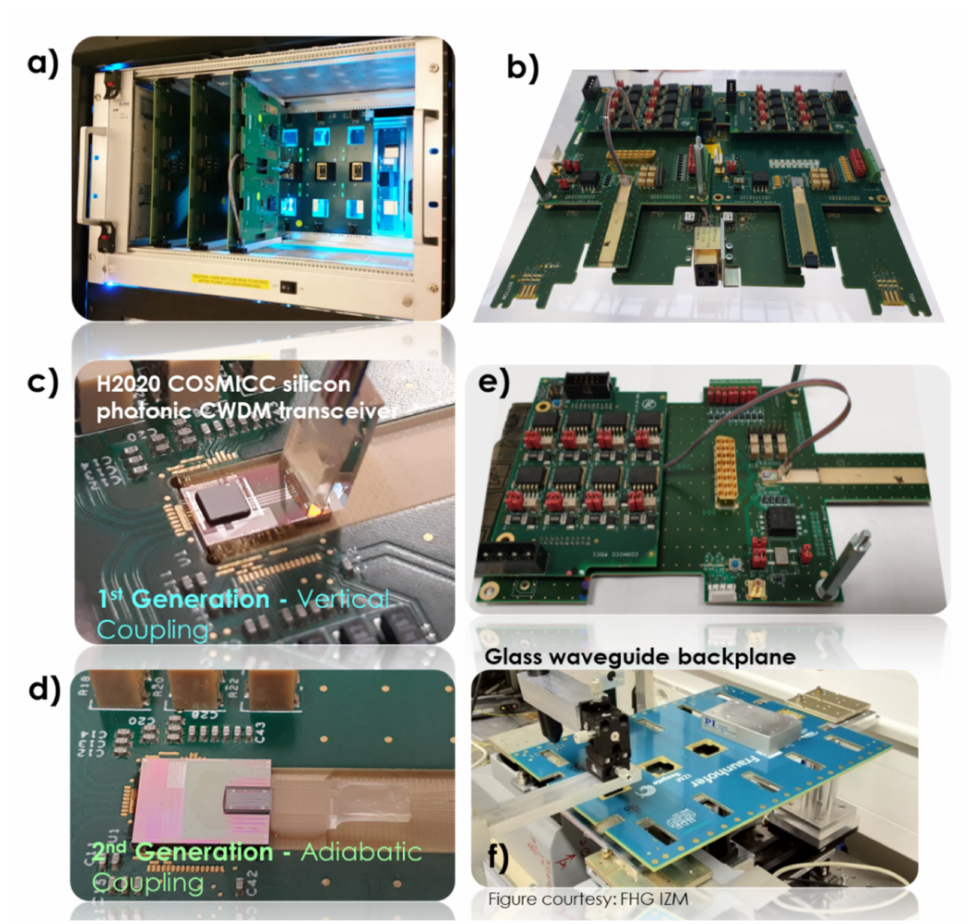
Figure 14. Images taken of EU H2020 “Aurora” hyperscale integrated photonic ecosystem demon- strator during its exhibition at ECOC 2019 in Dublin: ( a ) complete data center rack compliant Aurora platform; ( b ) test daughtercard, which includes two microphotonic test mezzanine cards hosting dif- ferent PICs; ( c ) silicon PIC with attached vertical grating coupler and fiber array unit; ( d ) silicon PIC with integrated adiabatic coupler and polymer waveguide ribbon; ( e ) microphotonic test mezzanine card; ( f ) glass waveguide backplane provided by Fraunhofer IZM